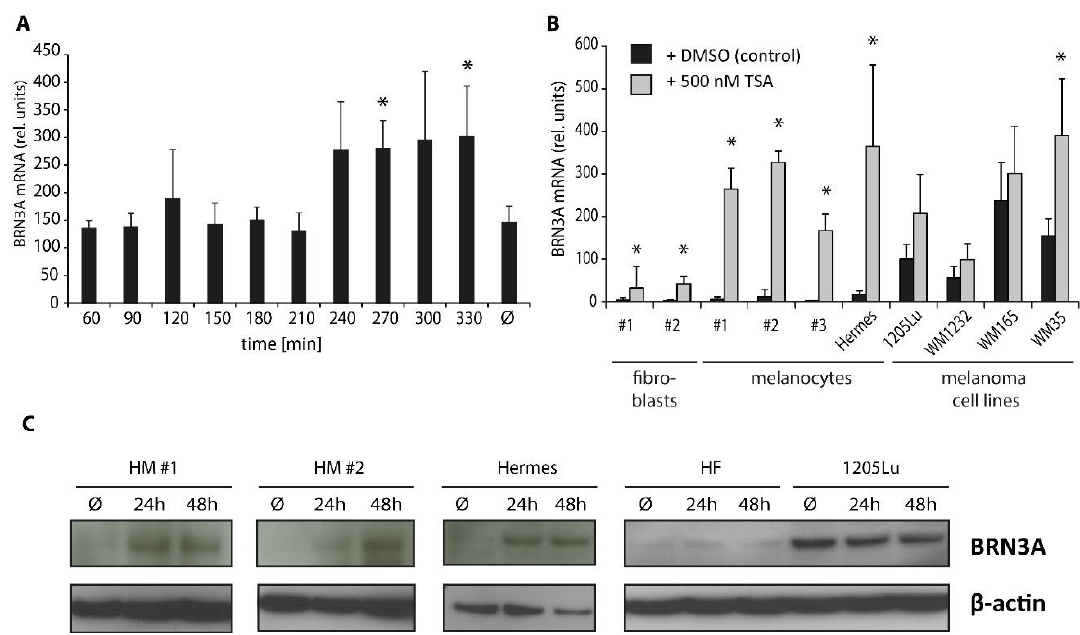
Figure 3. TSA induces BRN3A expression in melanocytes and melanoma cells. ( A ) Timeline analysis of BRN3A gene expression by qRT-PCR in human melanocytes (HM). HM were incubated with 500 nM TSA for up to 6 h. 0 min: before treatment, Ø: DMSO (control) after 6 h incubation. *: p < 0.05 vs. DMSO control, n = 3. ( B ) Relative BRN3A gene expression after panHDACi by TSA. Human fibroblasts (2 donors), melanocytes (3 donors and Hermes), and melanoma cell lines (1205Lu, WM1232, WM165, and WM35) were incubated with 500 nM TSA or DMSO (control) for 6 h. *: p < 0.05 vs. DMSO control, n = 3. ( C ) Protein expression of BRN3A in melanocytes (2 donors and Hermes), human fibroblasts (HF), and one melanoma cell line (1205Lu) after treatment with 500 nM TSA or DMSO (Ø , control) for 24 h and 48 h, respectively. Representative immunoblots are shown.